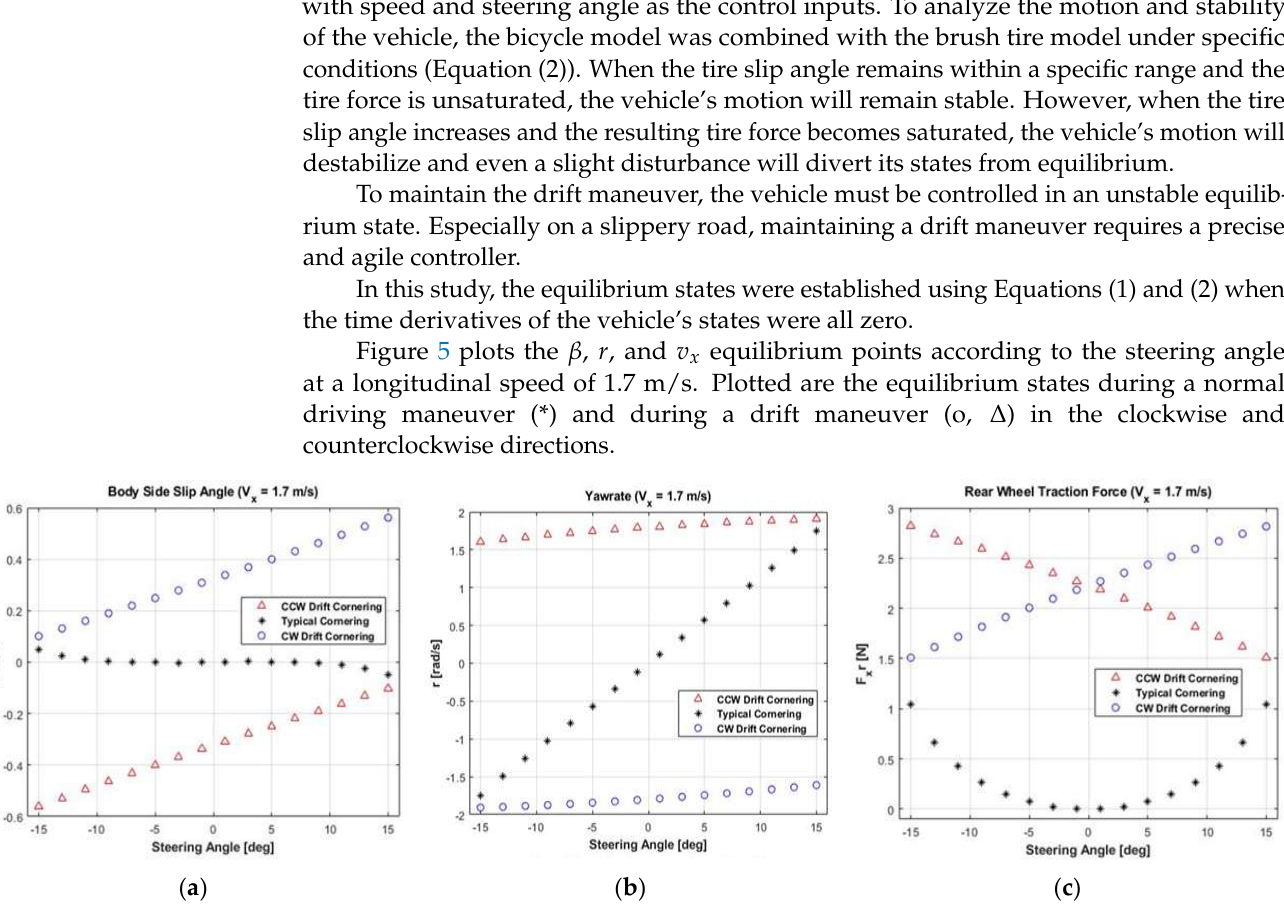
Figure 5. Equilibrium states of ( a ) sideslip angle ( β ), ( b ) yaw rate ( r ), and ( c ) rear wheel force ( F xr ) at a vehicle speed of 1.7 m/s